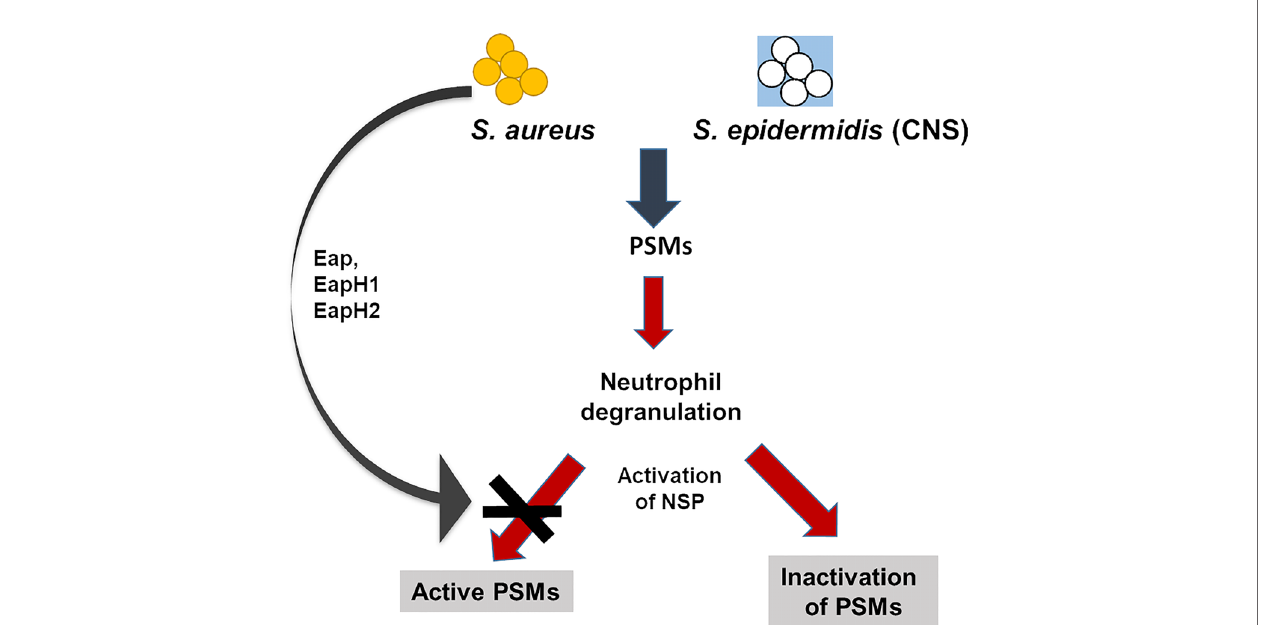
FIGURE 8 | In fl uence of NSPs on PSMs in S. aureus and S. epidermidis. PSMs of S. aureus and coagulase-negative S. epidermidis activate neutrophils, induce degranulation and release of the NSPs NE, CG and PR3. Active NSPs degrade PSMs of staphylococci. S. aureus , but not the coagulase-negative S. epidermidis secretes three NSP inhibitors, the extracellular adherence proteins (Eap, EapHI, EapHII), which speci fi cally inhibit NSPs. These NSP inhibitors prevent degradation of PSMs and thereby enhance the capability of S. aureus to survive better than S. epidermidis in the presence of